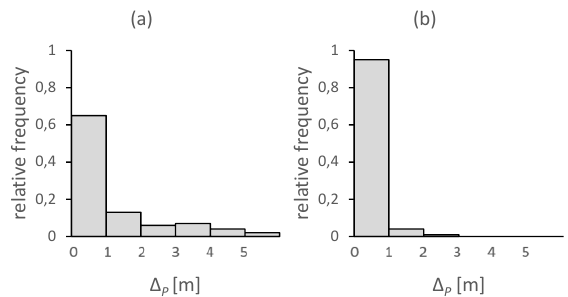
Figure 8. GUI for the crowd-based collection of MBB